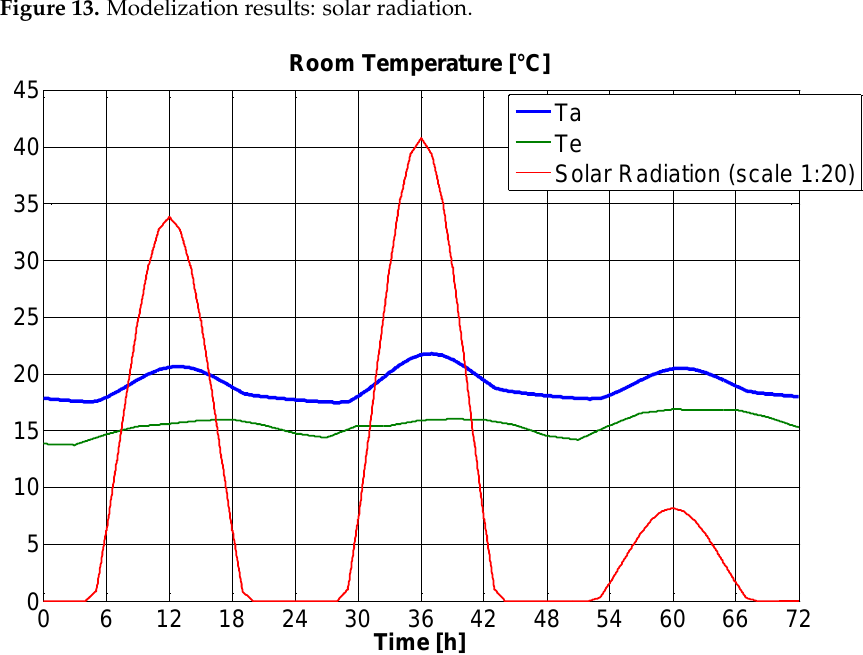
Figure 14. Modelization results with no control actions: room temperature.